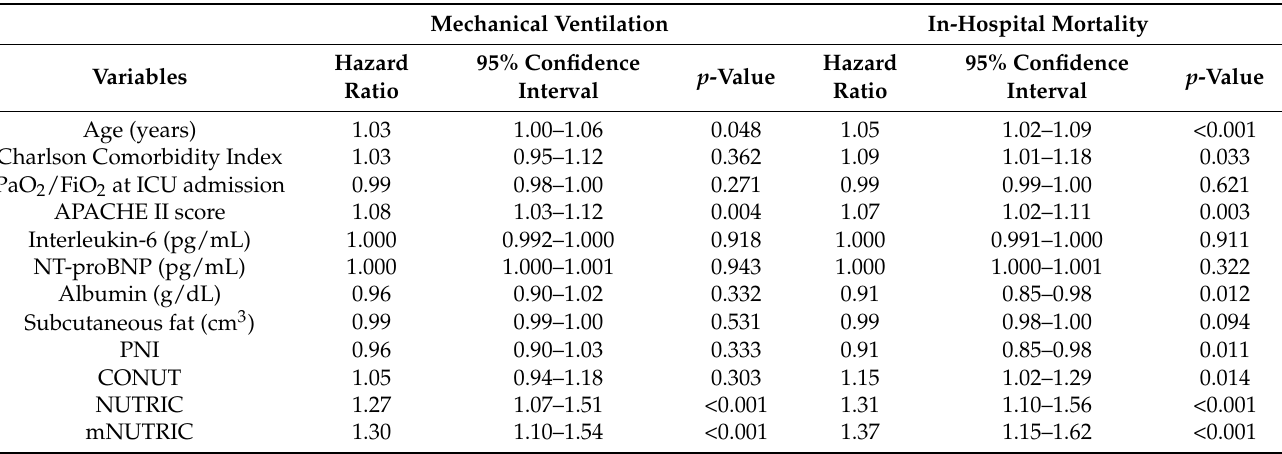
Table 3. Univariate Cox proportional hazards analysis for the risk of mechanical ventilation and in-hospital